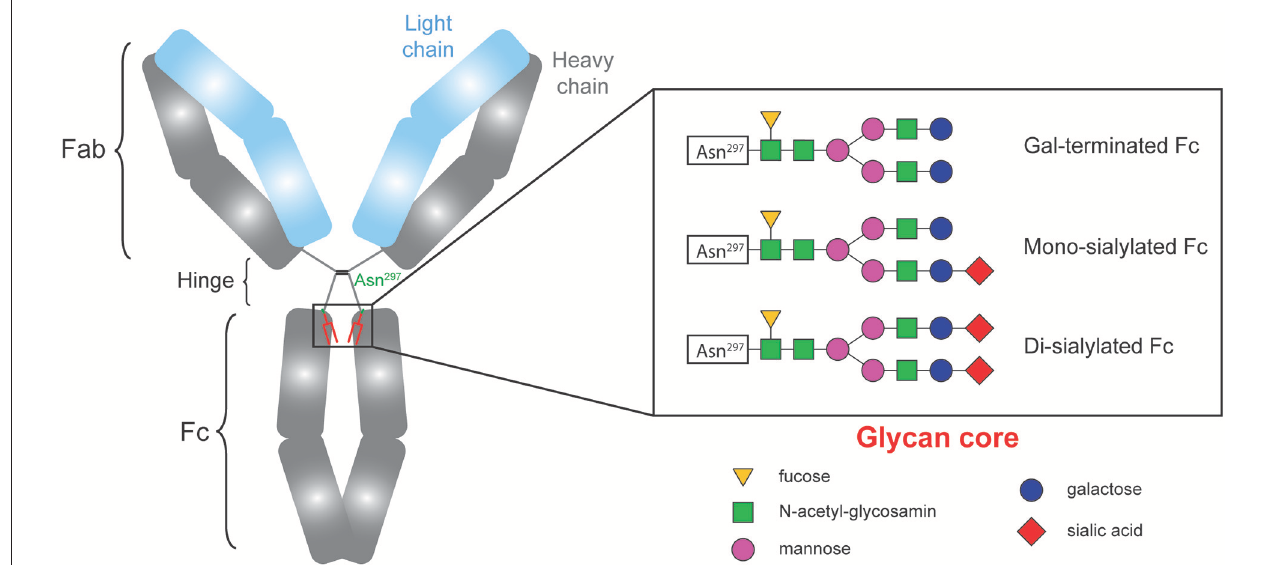
FIGURE 1 | The sialylation status of immunoglobulins Fc fragment is